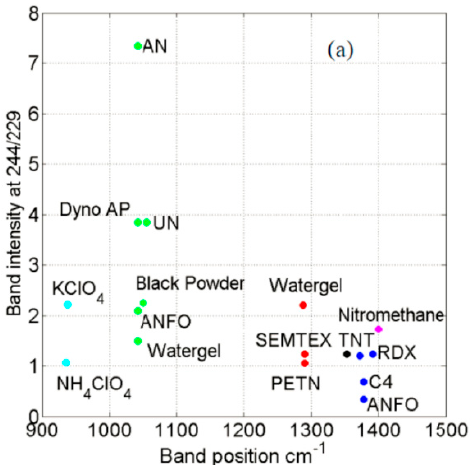
Figure 13. Dual-excitation-wavelength signatures of measured explosives. Adapted from [126], with permission from © 2013 SPIE.